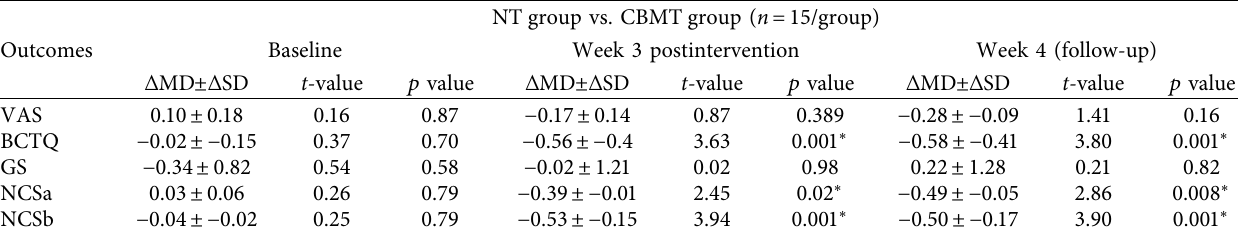
Table 3: Between-group comparison for the scores of the outcome measures using unpaired t